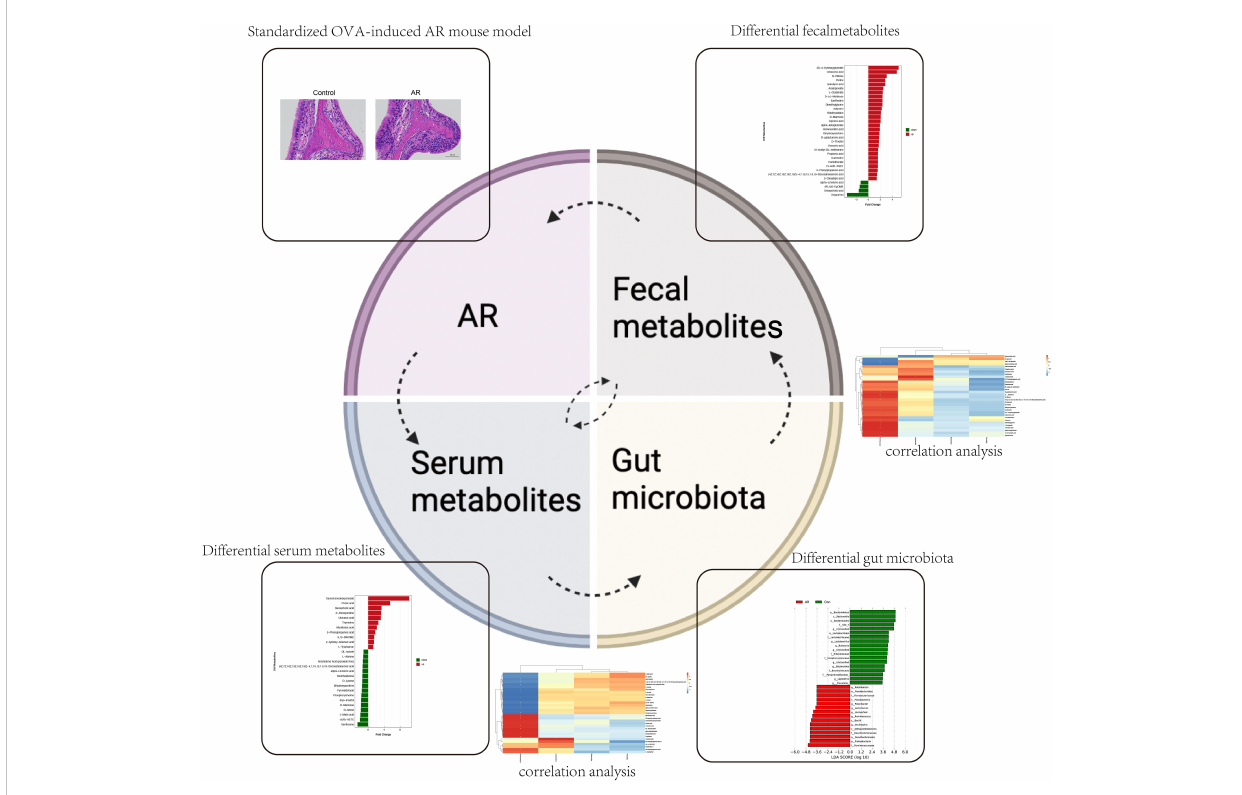
FIGURE 10 The OVA-alum AR model disturbs gut microbiota composition and alters the fecal and serum metabolic patterns and the correction among the